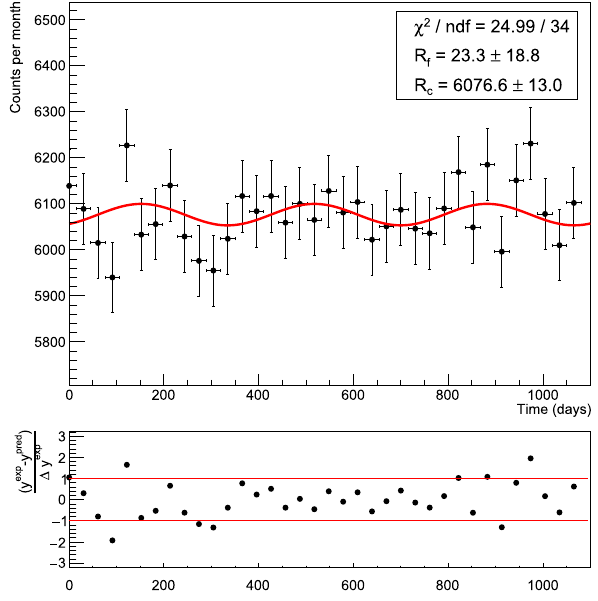
Fig. 1 Simulated fluctuations in background only model, with R b = 1 cpd/kg/keV over 3 years fit to R ( t ) = R c + R f cos ω t